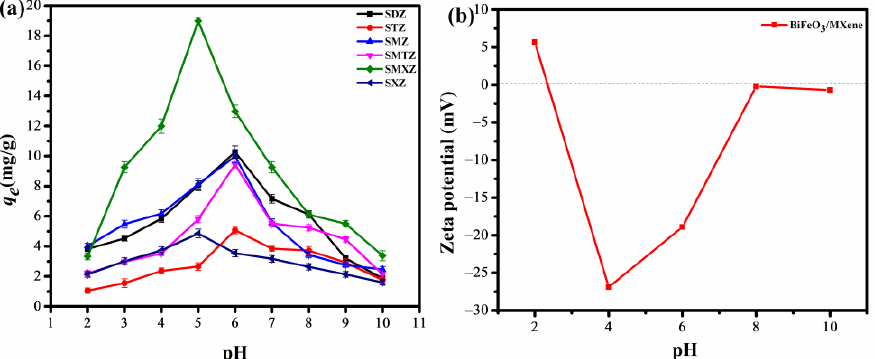
Figure 6. ( a ) Effect of pH on adsorption capacity of sulfonamides, ( b ) zeta potential of BiFeO 3